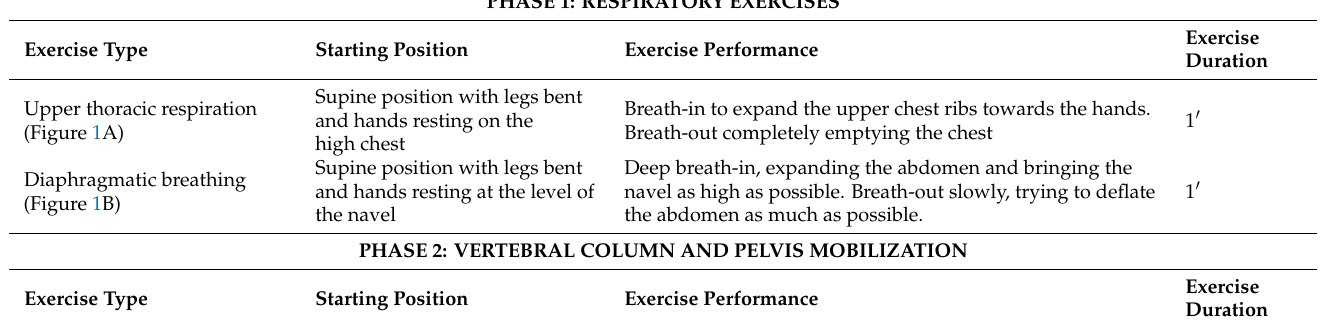
Table 1. Active stretching exercise